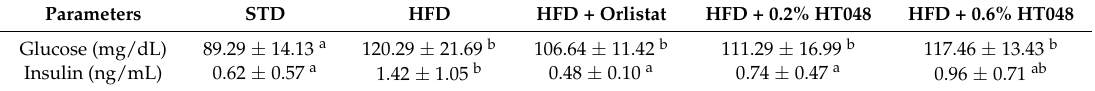
Table 2. Effect of HT048 on serum glucose, and insulin in HFD-fed obese rats.